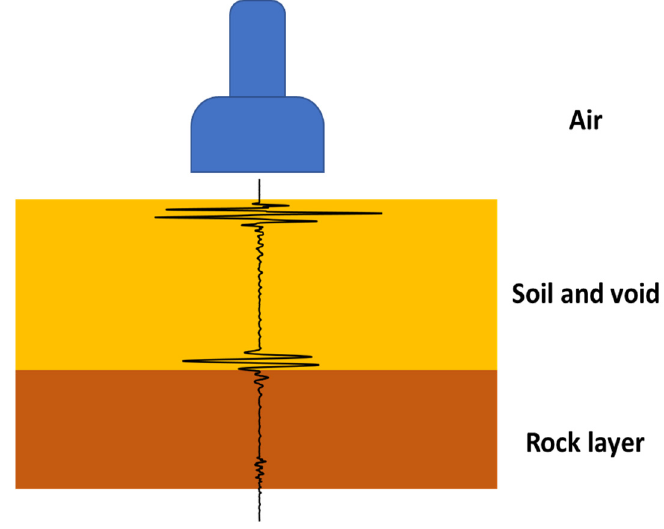
Figure 1. Material model of the layers used for simulations.